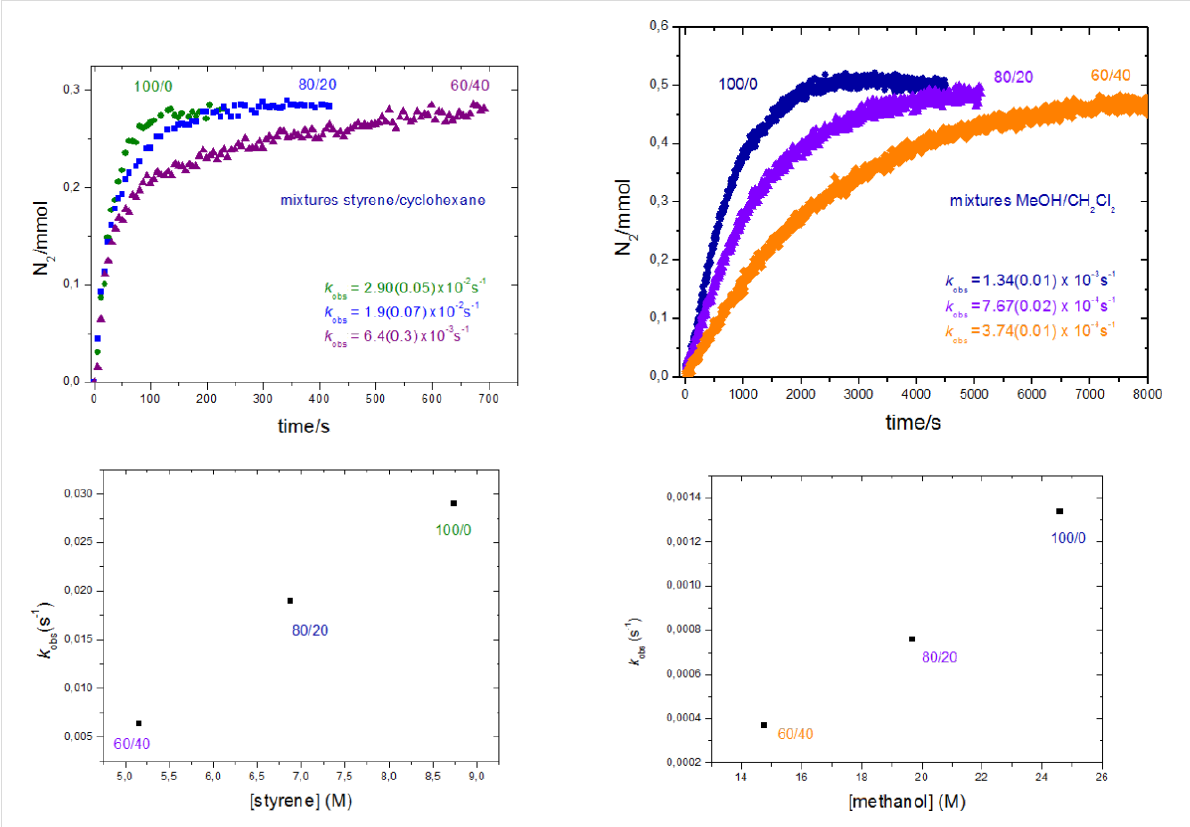
Figure 2: Top: Plots of evolved nitrogen with time for the reactions of EDA with styrene (left) or methanol (right) varying the relative substrate:catalyst ratio, at a constant catalyst value. Bottom: Plots of k obs vs substrate concentration showing a direct correlation between both magnitudes.